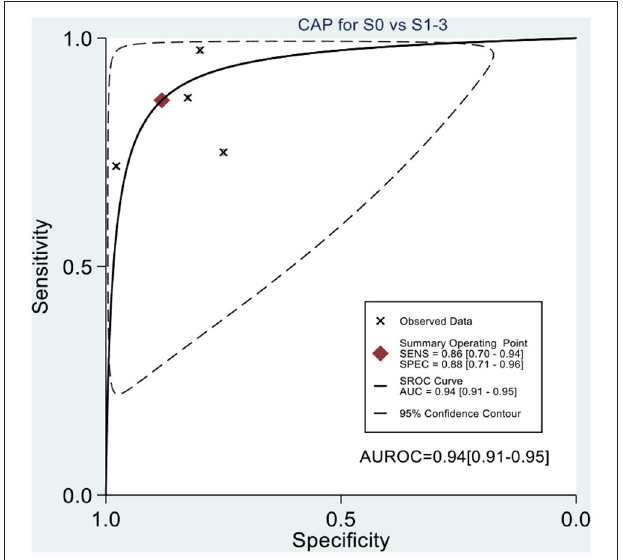
FIGURE 3 | Hierarchical summary receiver operating characteristic (HSROC) curves for the detection of hepatic steatosis (S0 vs. S1–S3) by using MRI-PDFF or TE-CAP.